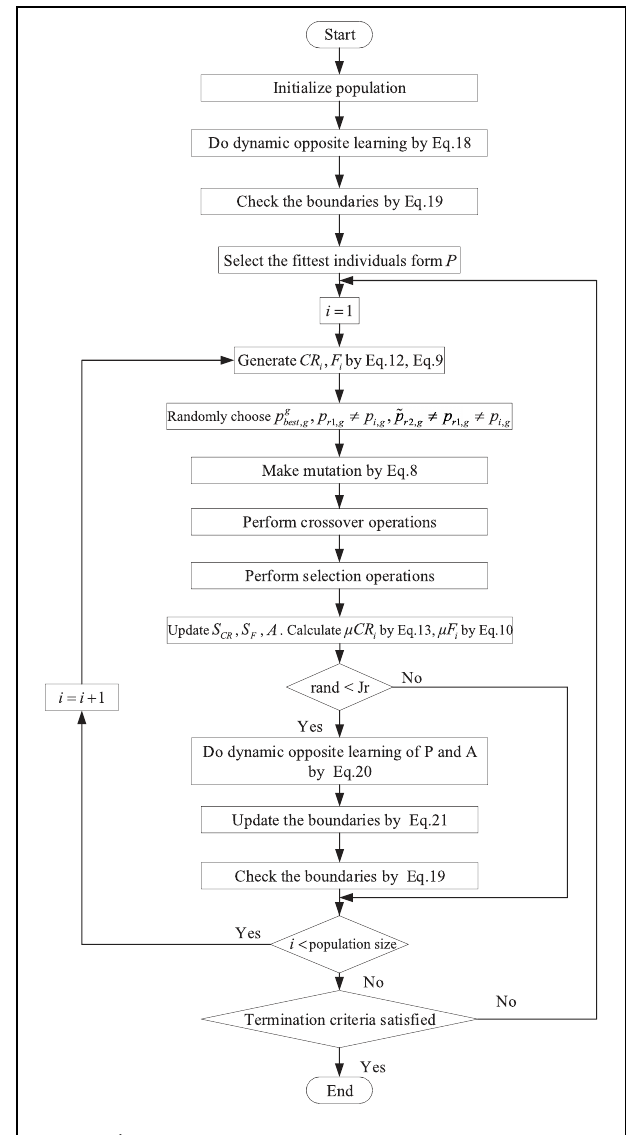
FIGURE 5 | Flowchart of